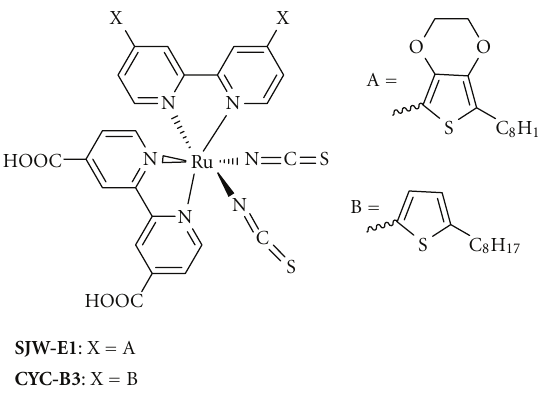
Figure 19: Molecular structures of SJW-E1 and CYC-B3 (taken from [37]).